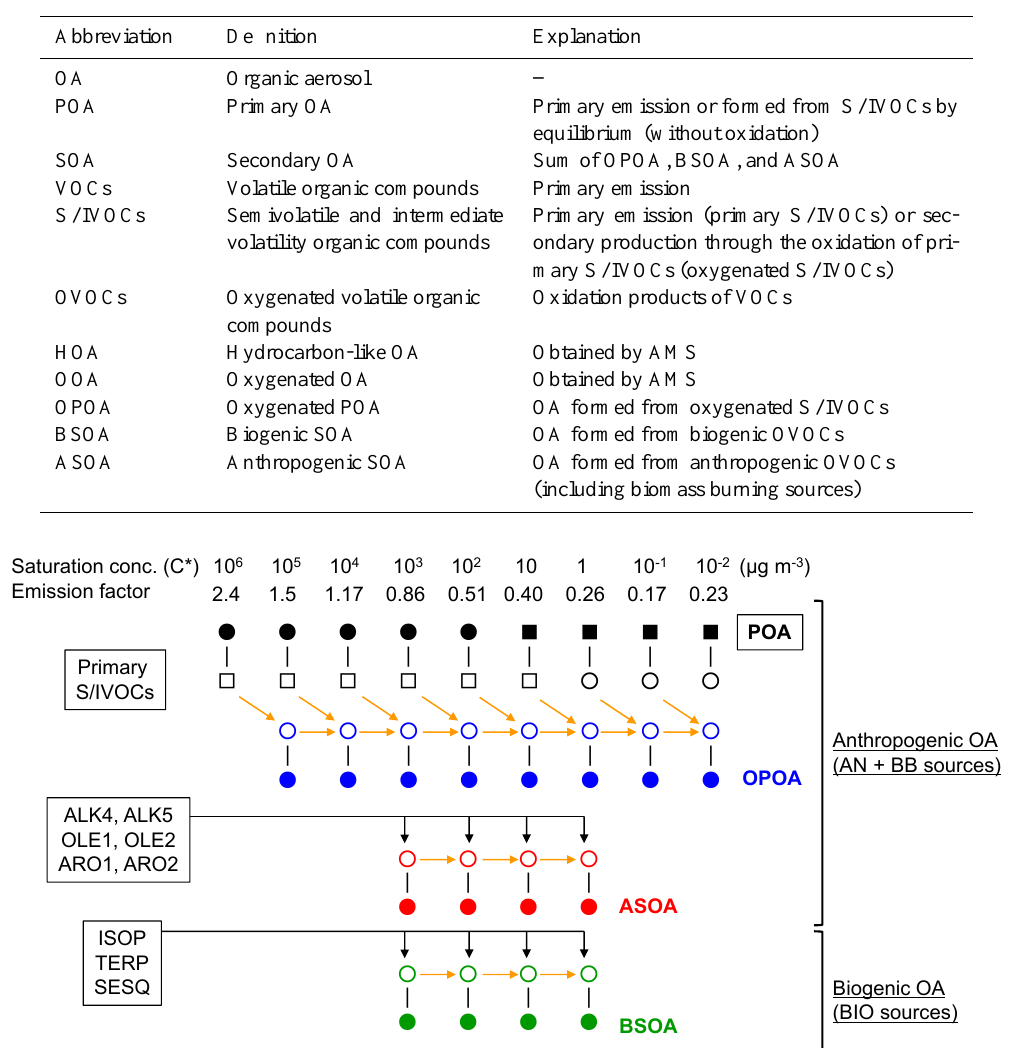
Table 1. Abbreviations for organic vapors and aerosols used in this study.